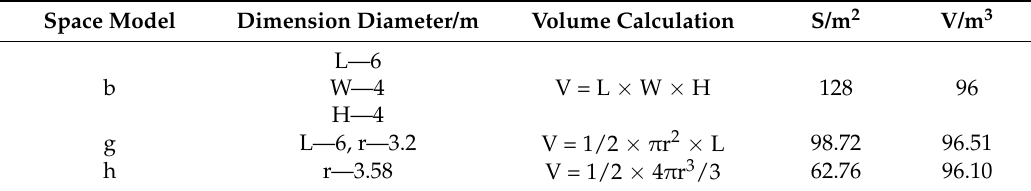
Table 5. The dimensions of closed-space models with different volumes.